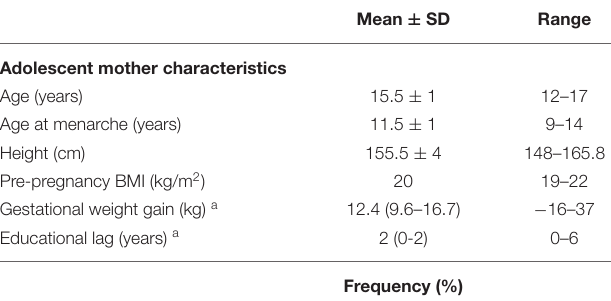
TABLE 1 | General characteristics of adolescent mothers and their offspring, n = 186